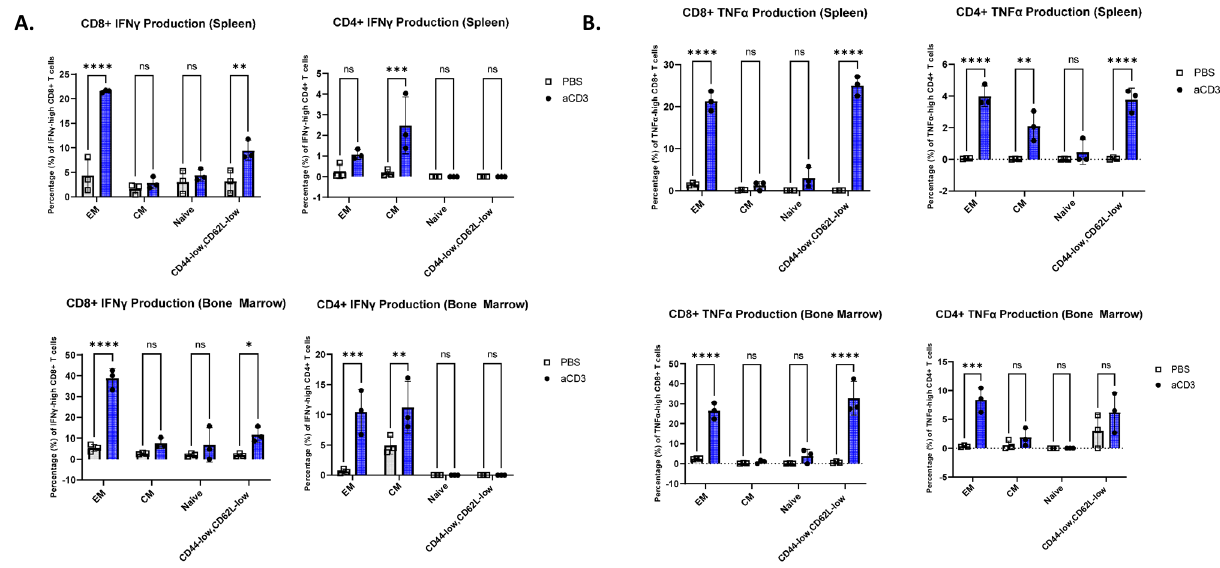
Figure 5. CD44-low/CD62L-low T cells can produce inflammatory cytokines. ( A ) The percentage of IFNγ- high CD8+ (left) and CD4+ (right) T cells within each compartment of CD44/62L gate in the spleen and bone marrow. Grey rectangle = PBS-treated, Blue = αCD3-treated. (*) indicates statistical significance, P value = 0.0241. (**) indicates statistical significance, P value < 0.01. (***) indicates statistical significance, P value < 0.001. (****) indicates statistical significance, P value < 0.0001. ( B ) The percentage of TNFα-high CD8 + (left) and CD4+ (right) T cells within each compartment of CD44/62L gate in the spleen and bone marrow. Grey rectangle = PBS-treated, Blue = αCD3-treated. (**) indicates statistical significance, P value = 0.0012. (***) indicates statistical significance, P value = 0.0003. (****) indicates statistical significance, P value <